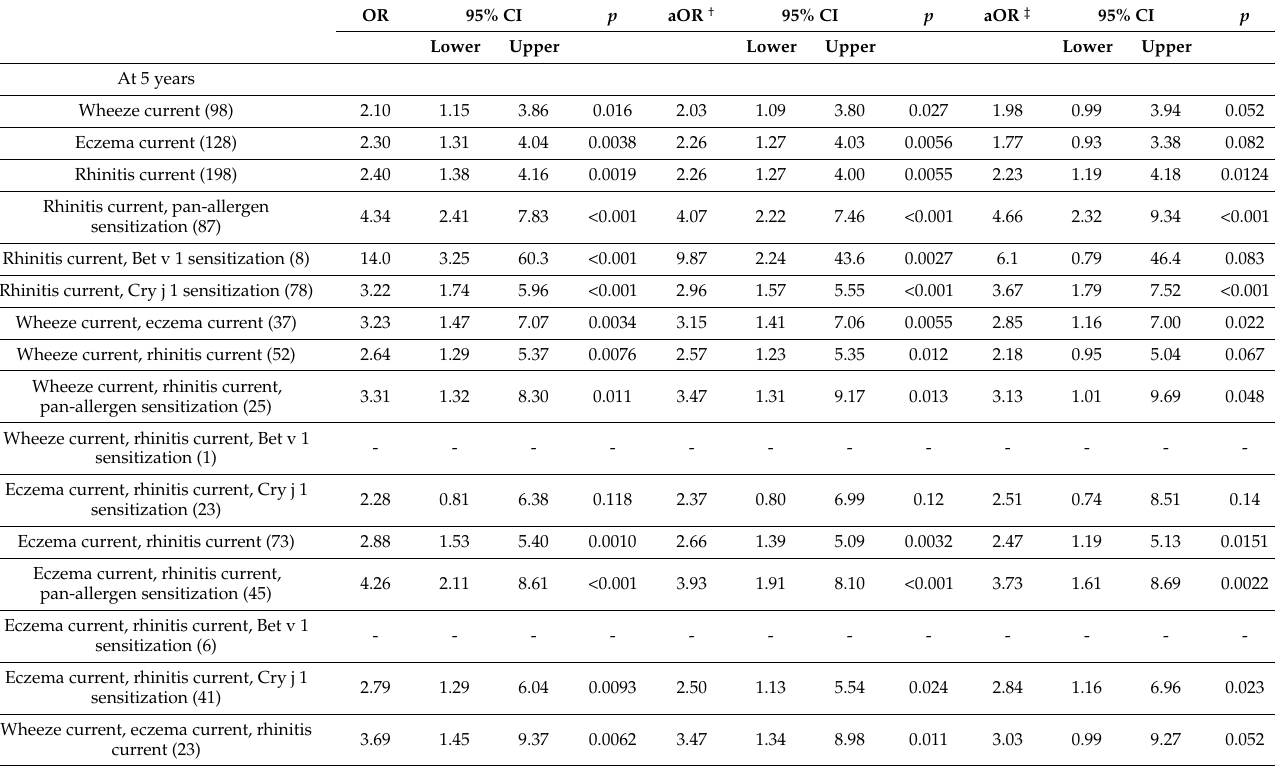
Table 2. Association of allergic diseases at 5 years with PFAS at 13 years of